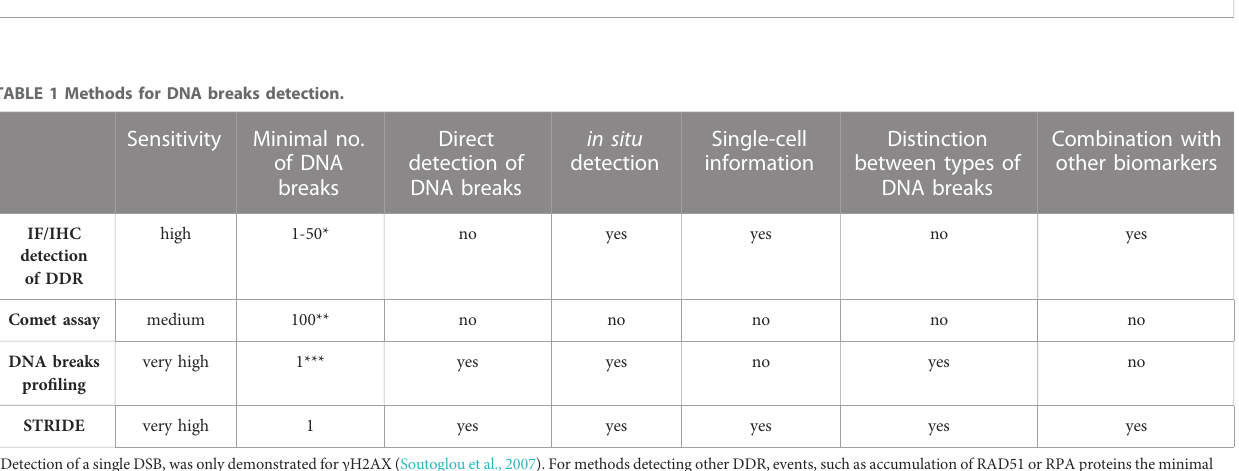
FIGURE 1 Methods for DNA breaks detection, as presented in the paper. While STRIDE, DNA breaks pro fi ling and the comet assay are DDR-independent, IF detection of repair proteins and histone modi fi cations relies on active DNA surveillance mechanisms. A schematic representation of each of the method is presented with a list of most important features.